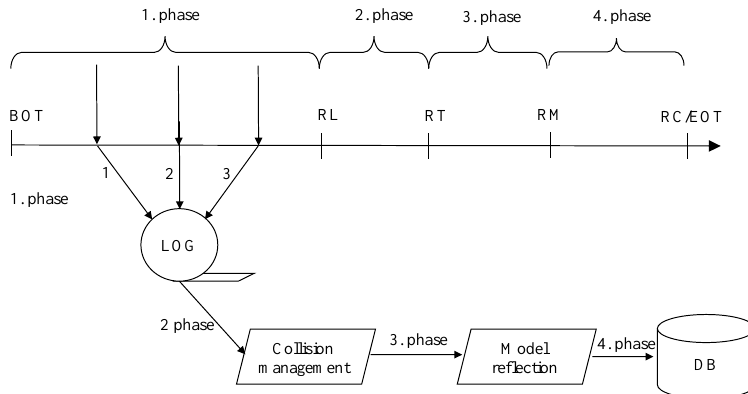
Figure 8. Four-phase Commit protocol.